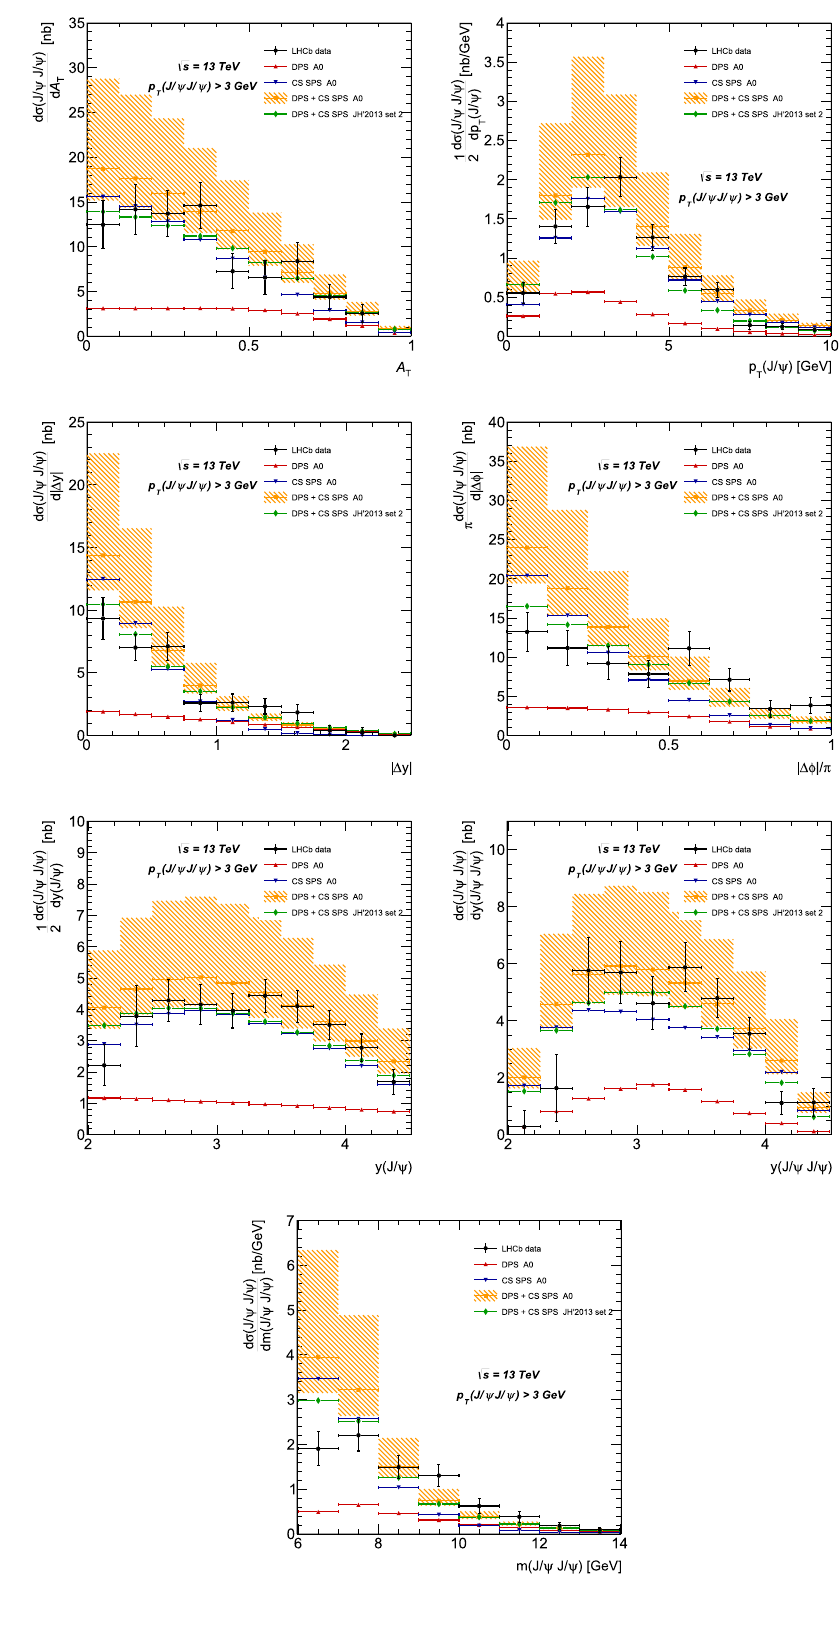
Fig. 10 Prompt double J /ψ production cross sections as functions of different kinematical variables calculated at p T ( J /ψ, J /ψ) > 3 GeV and √ s = 13 TeV. Other kinematical cuts applied are described in the